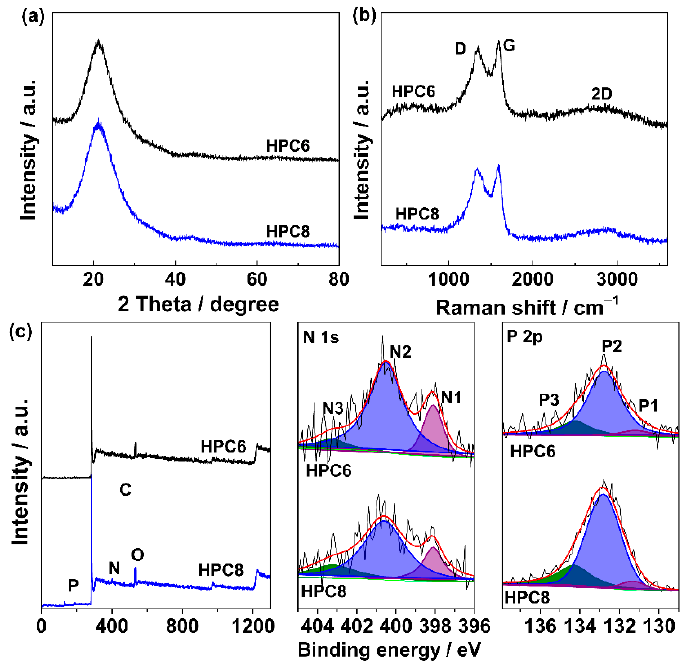
Figure 3. ( a ) XRD patterns, ( b ) Raman spectra, ( c ) XPS convey, N 1s and P 2p spectra for HPCs.